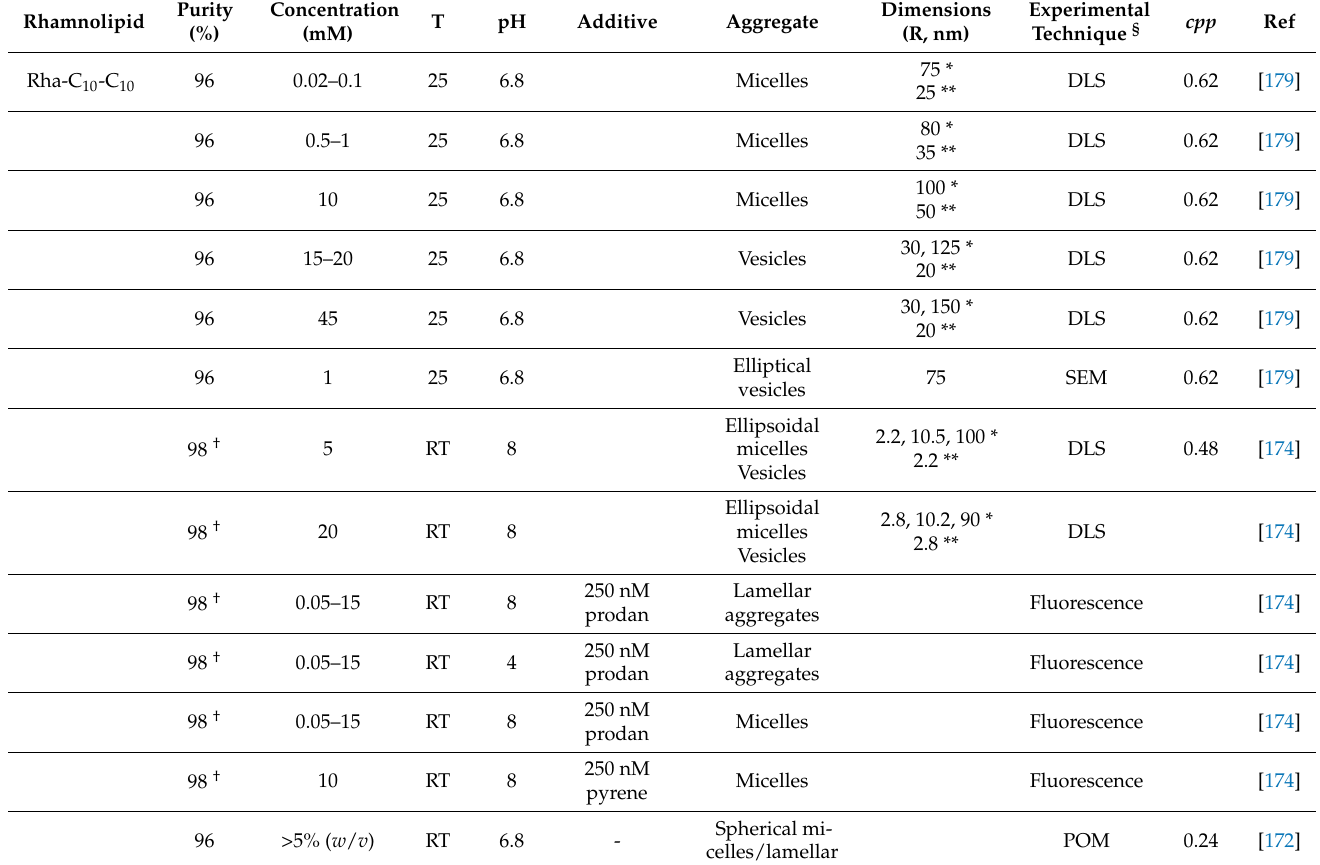
Table 4. Aggregation properties of “pure” rhamnolipids obtained either by purification of microbial extracts or by modified biosynthetic routes. Based on the rhamnolipid pKa = 5.5, rhamnolipids are expected to be neutral at pH < 5.5 and negatively charged at pH >